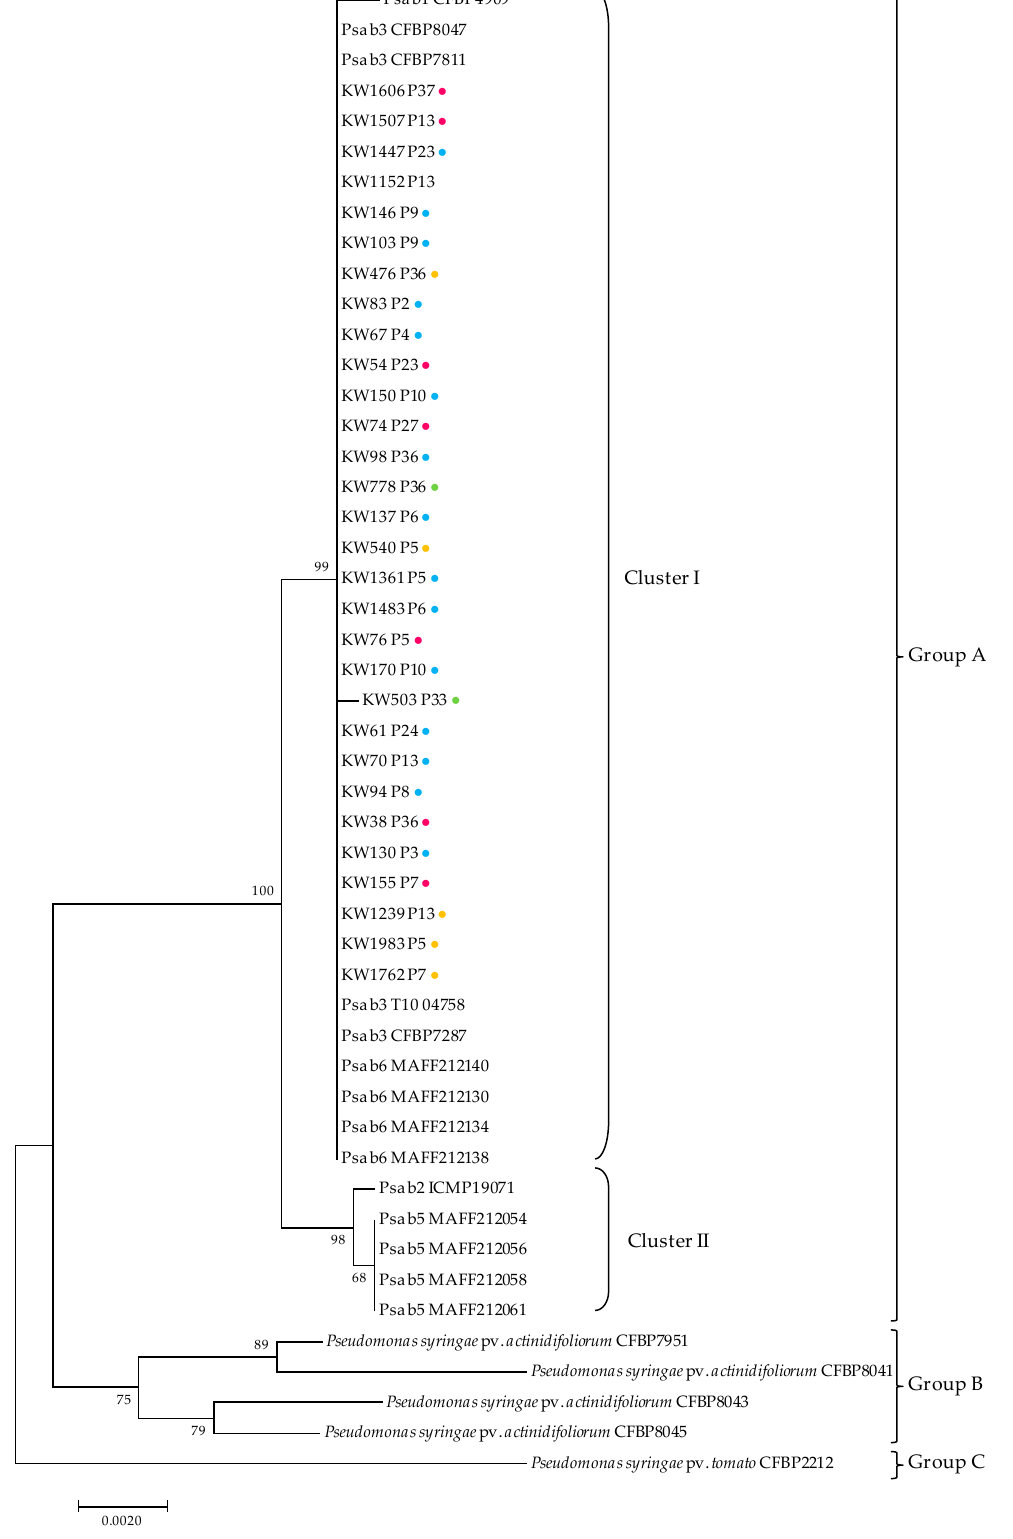
Figure 3. Maximum likelihood tree inferred from the concatenated partial sequences of four housekeeping genes ( gapA , gltA , gyrB , and rpoD ) from selected Psa strains (Table S2). P. syringae pv. tomato was used as outgroup. Labels P1 to P36 indicate the Psa BOX profile; b, biovar; bootstrap support values (1000 replicates) are indicated at each node. Scale bar, 0.02 inferred nucleotide substitutions per nucleotide position. Blue dot, profiles isolated from orchard A; pink, from orchard B; yellow, from orchard C; green, from orchard